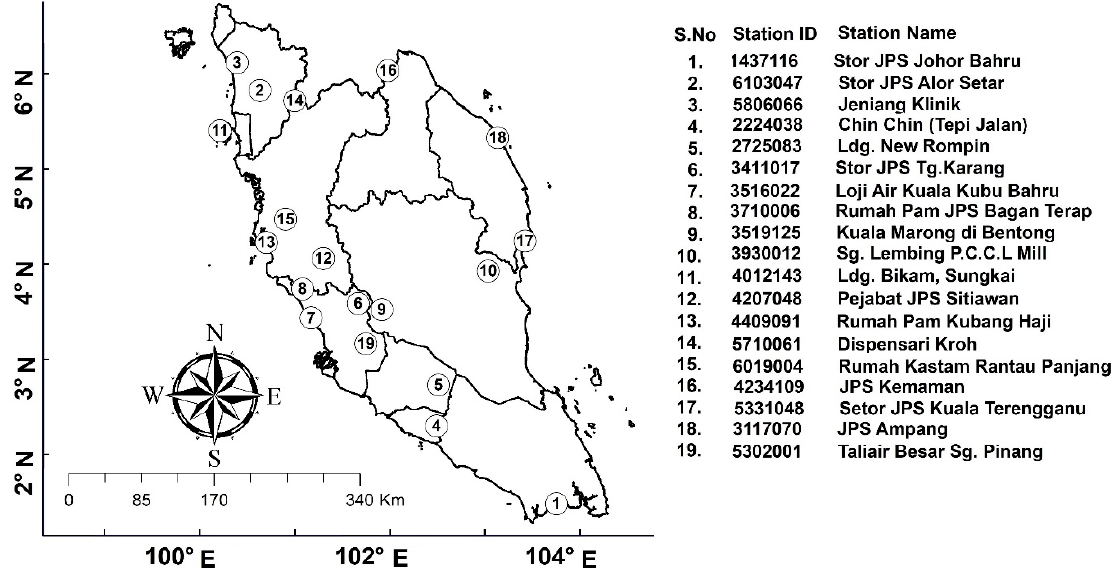
Figure 1. Location of the selected rain gauges on the map of peninsular Malaysia. The number in circle represents the station name and ID, as shown on the right side in figure.